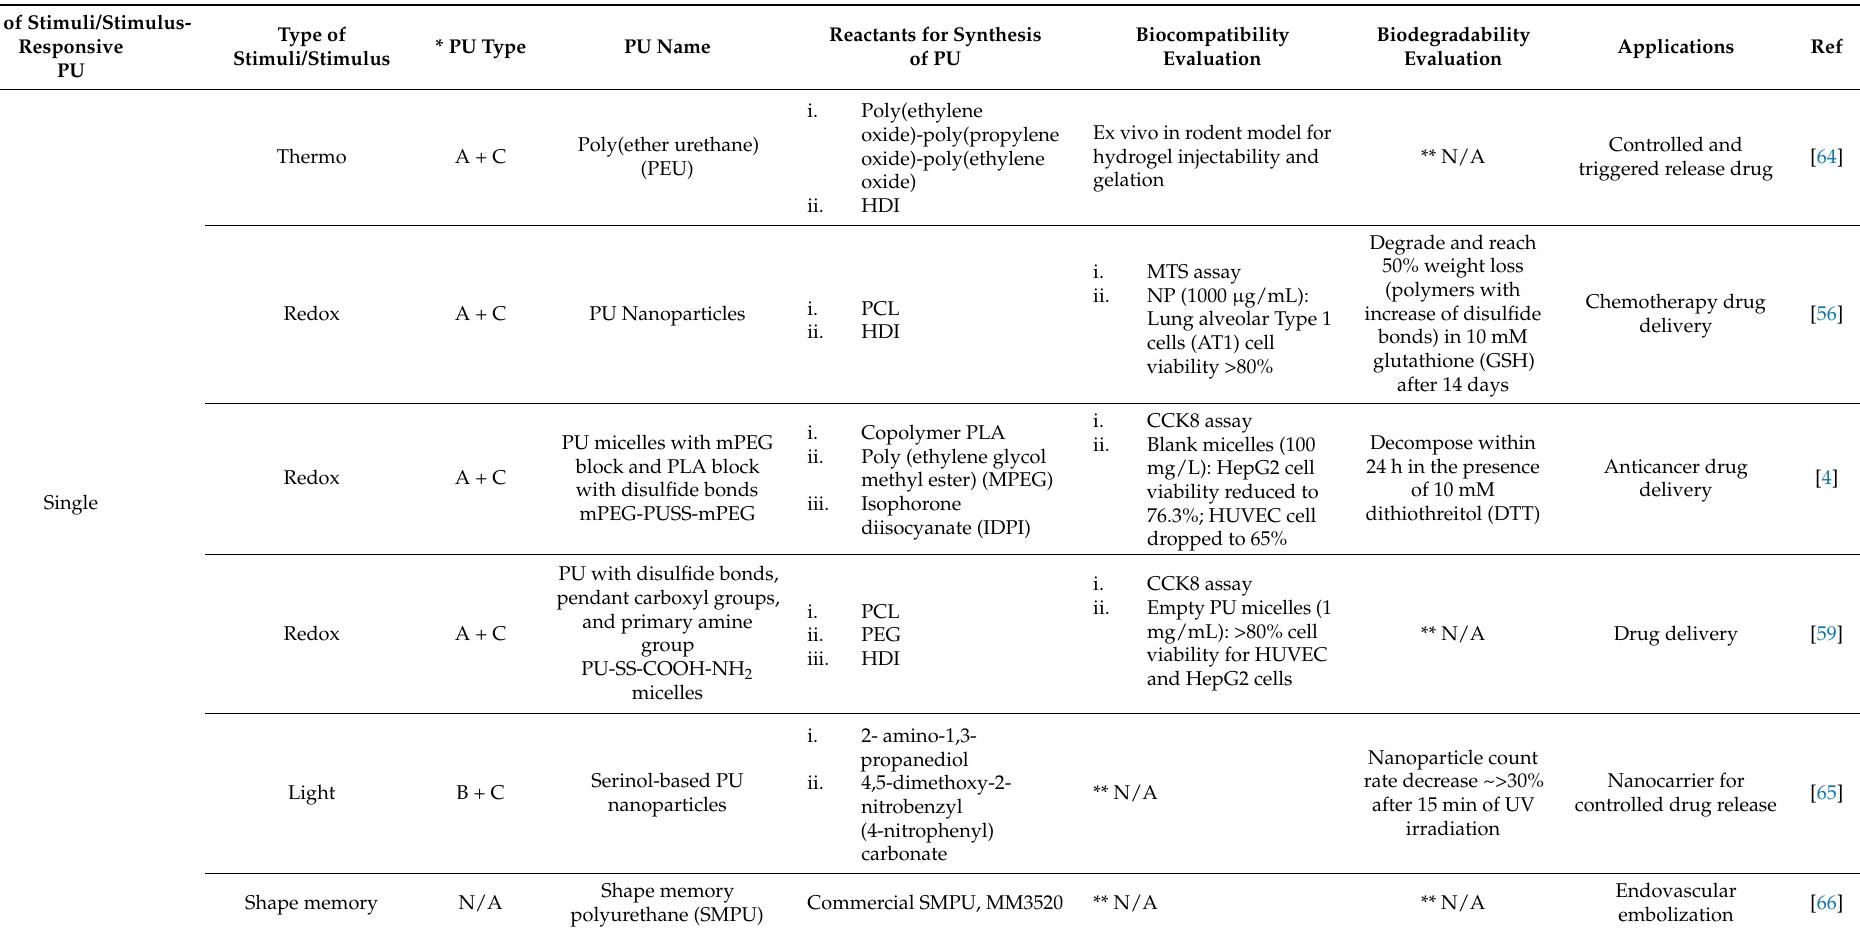
Table 2. Types of stimulus-responsive polyurethanes used in biomedical and drug delivery applications, and their biocompatibility and biodegradability evaluation (excluding